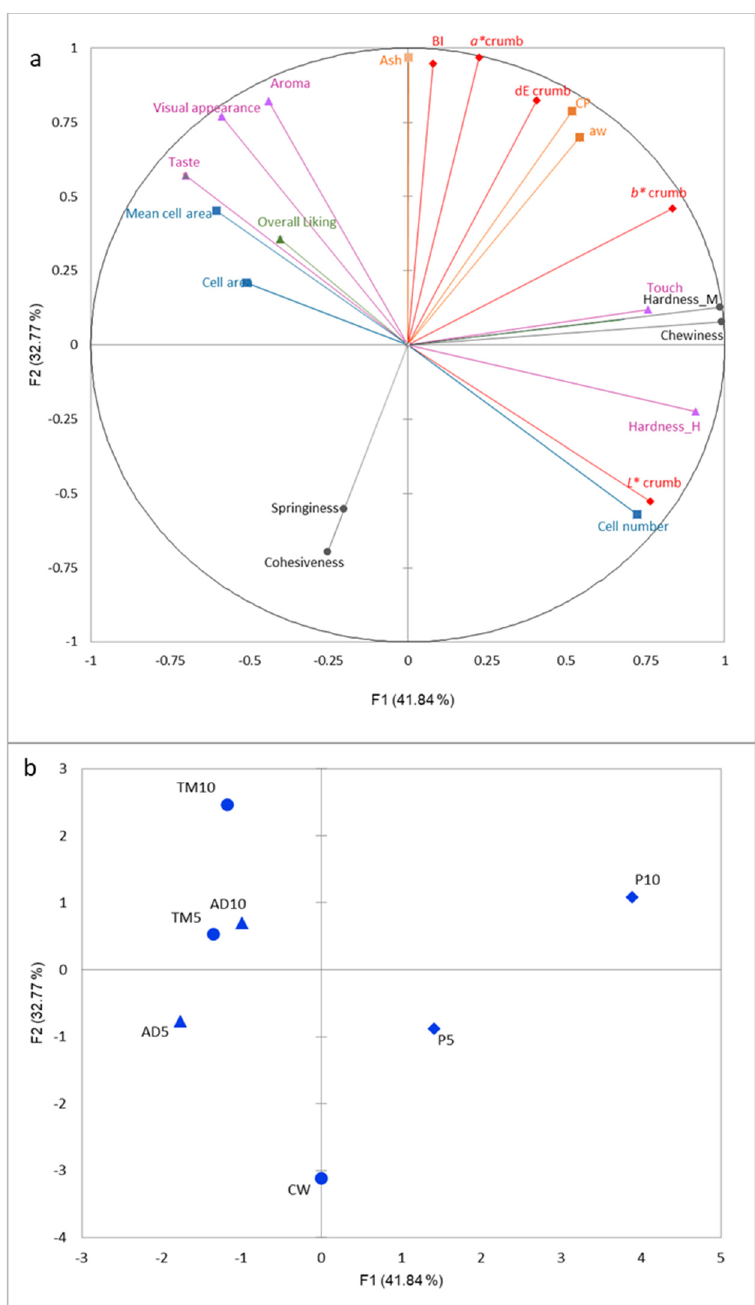
Figure 5. Multi factor analysis (MFA) score plot of loading plot of instrumental and hedonic attributes ( a ) and bread samples ( b ). CW: Control; P5: Pea 5%; P10: Pea 10%; TM5: T. molitor 5%; TM10: T. molitor 10%; AD5: A. diaperinus 5%; AD10: A. diaperinus 10%.